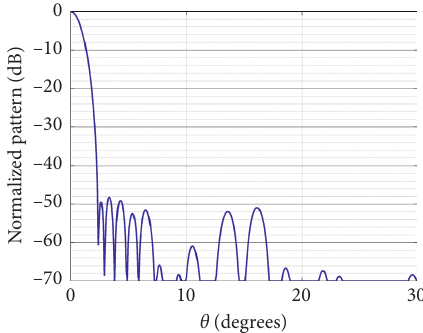
� 44, N � 36, and t r